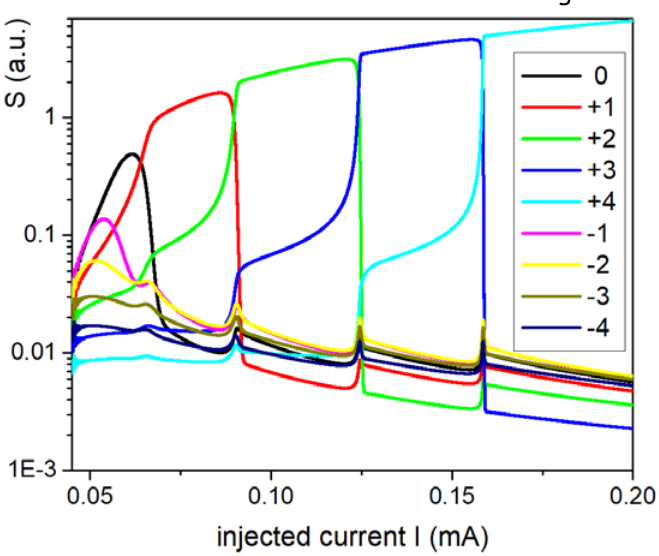
Figure 2. Photon number S in the dependence of injected current